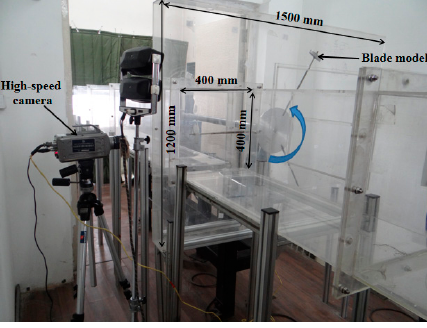
Figure 4. Diagram of actual test section.